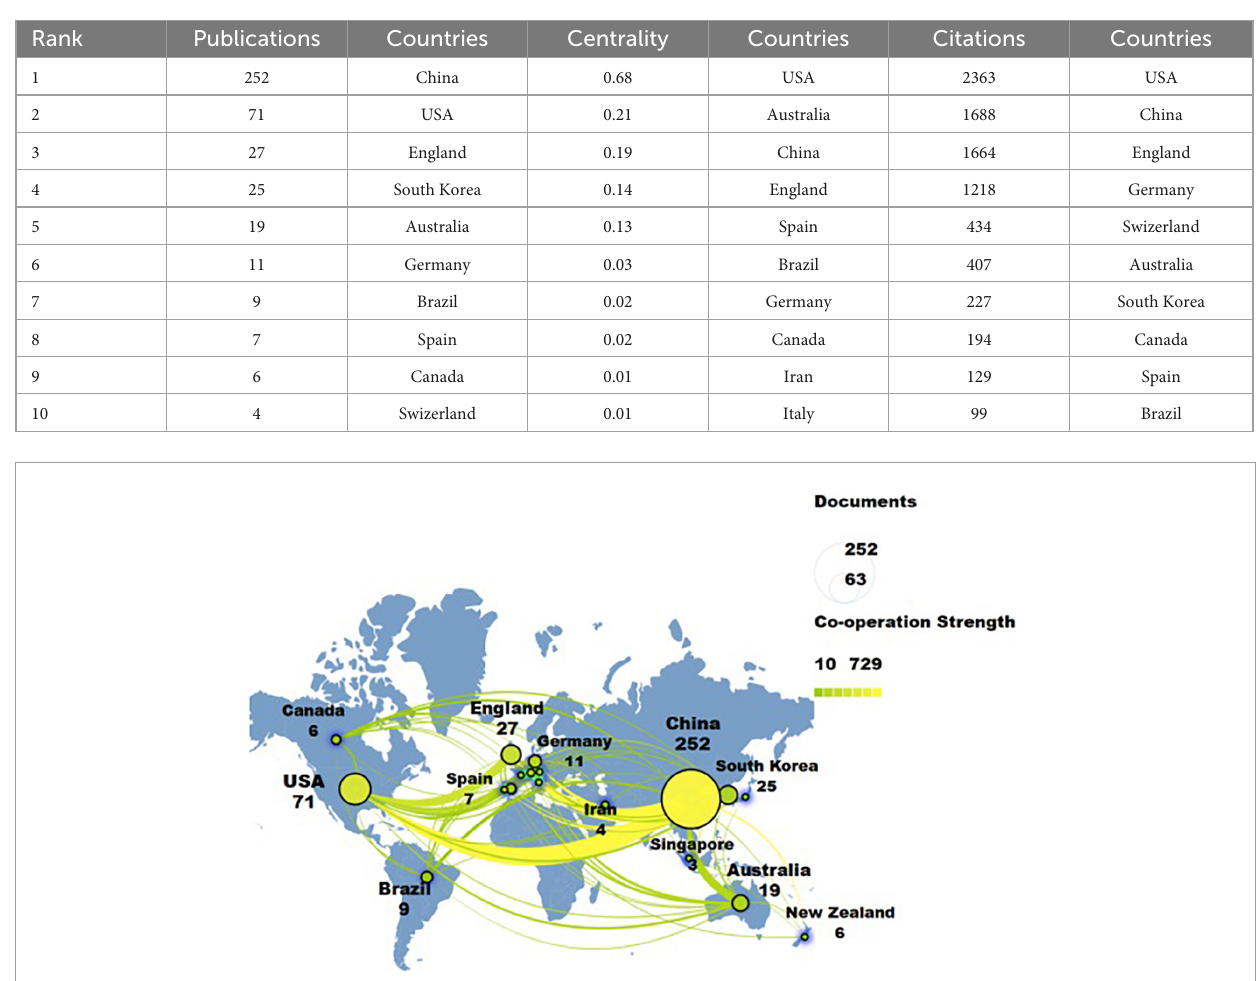
TABLE 3 Top 10 countries related to Chinese non-pharmacological therapy on KOA.